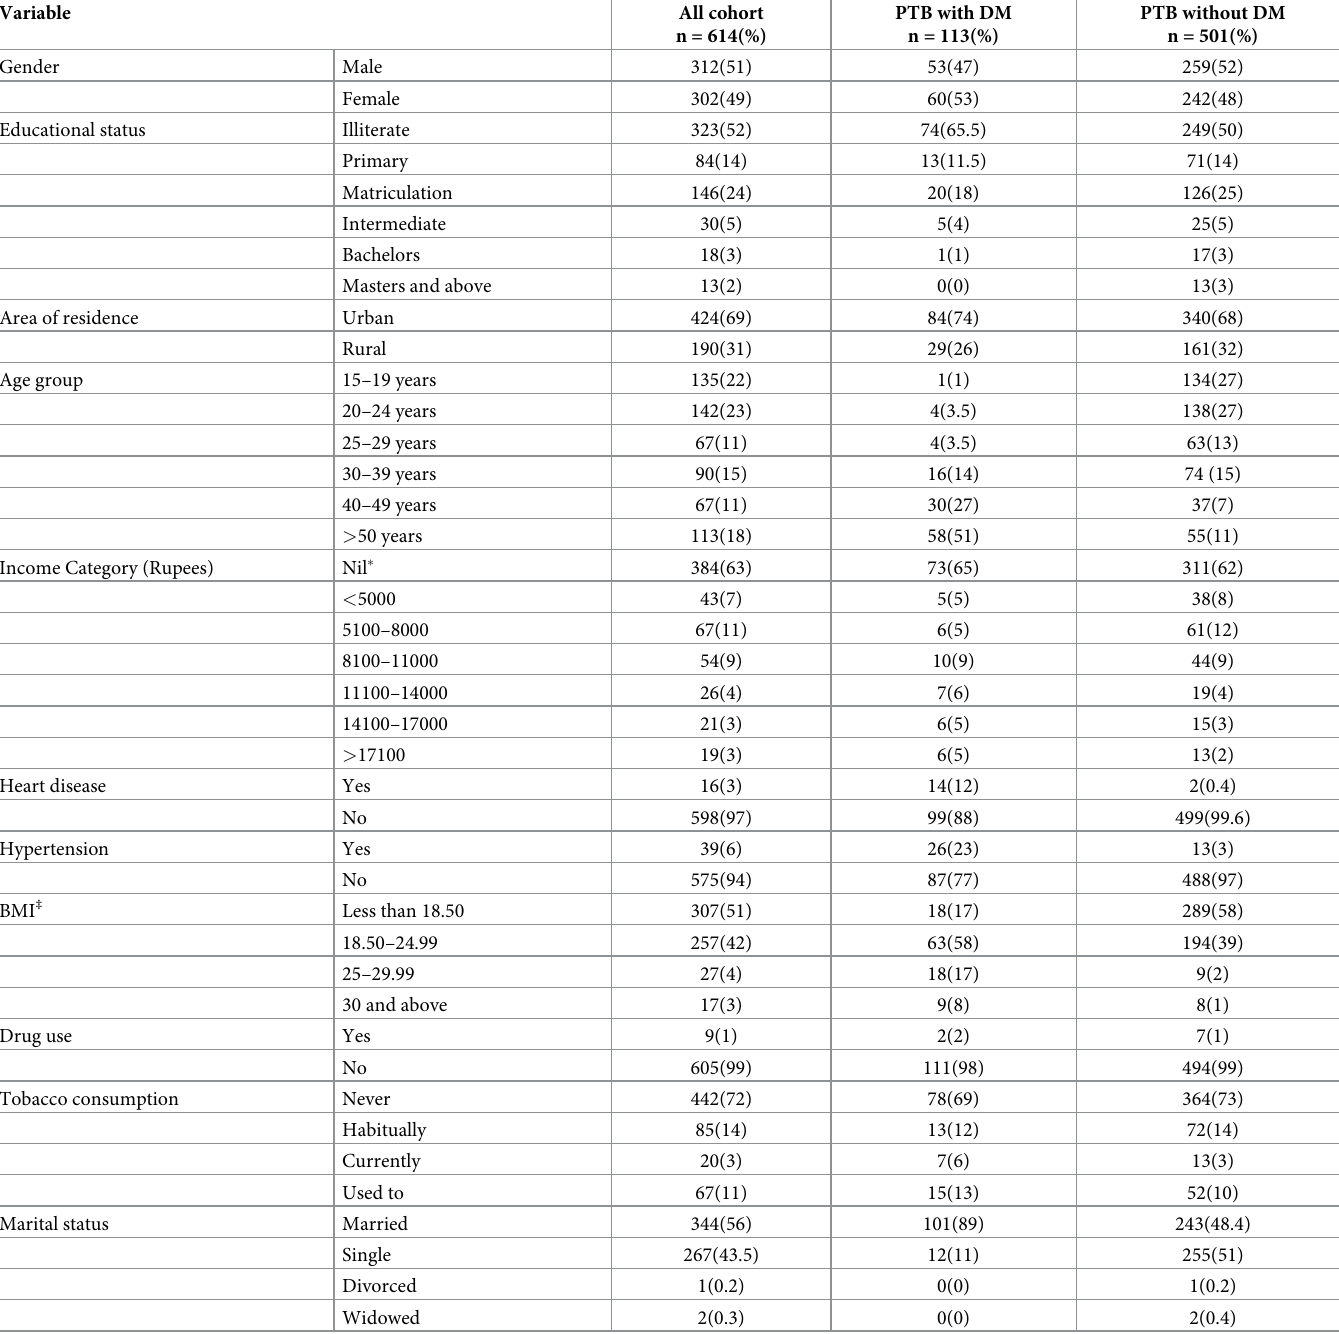
Table 1. Socio-demographic, lifestyle and co-morbidity characteristics of 614 new pulmonary tuberculosis patients with (n = 113) or without diabetes mellitus (n = 501) presenting at Gulab Devi Chest Hospital,